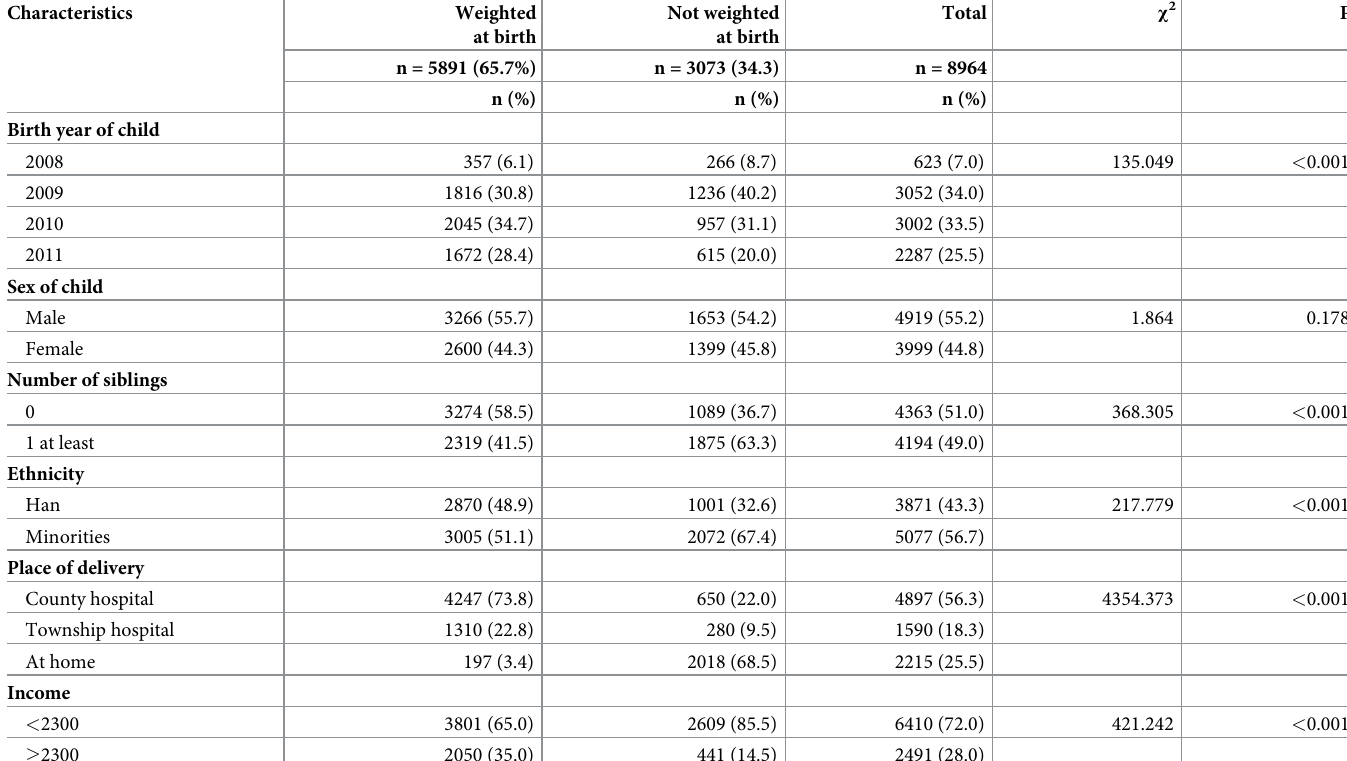
Table 1. Socio-demographic characteristics among children weighted or not at birth in 42 counties in Western China (N = 8964, 2011).